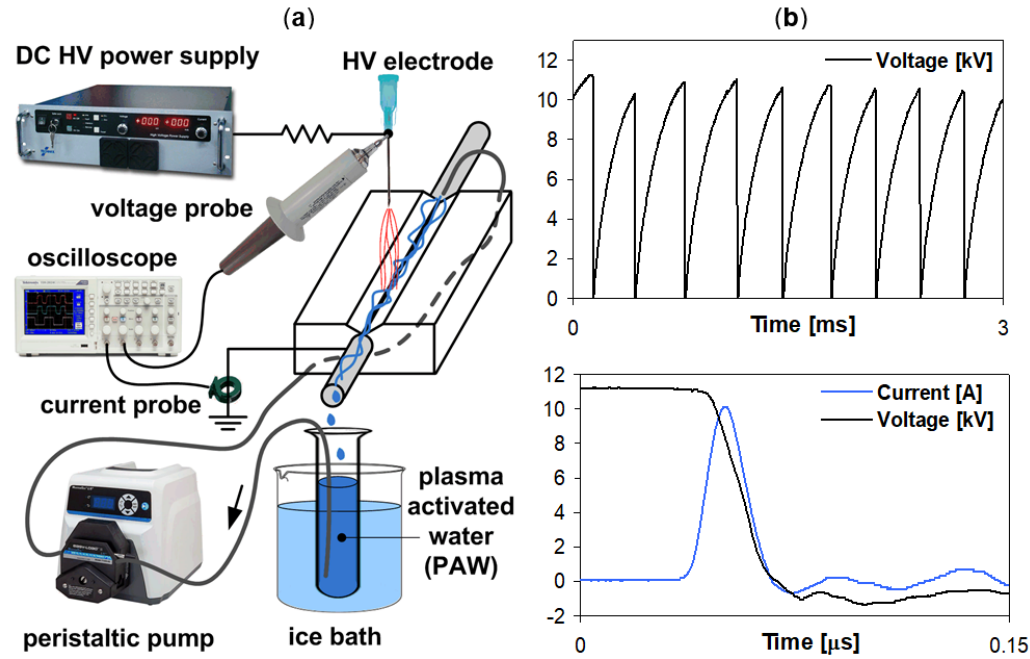
Figure 1. ( a ) The scheme of experimental setup and ( b ) characteristic voltage and current waveforms of self-pulsing transient spark discharge in two different timescales.